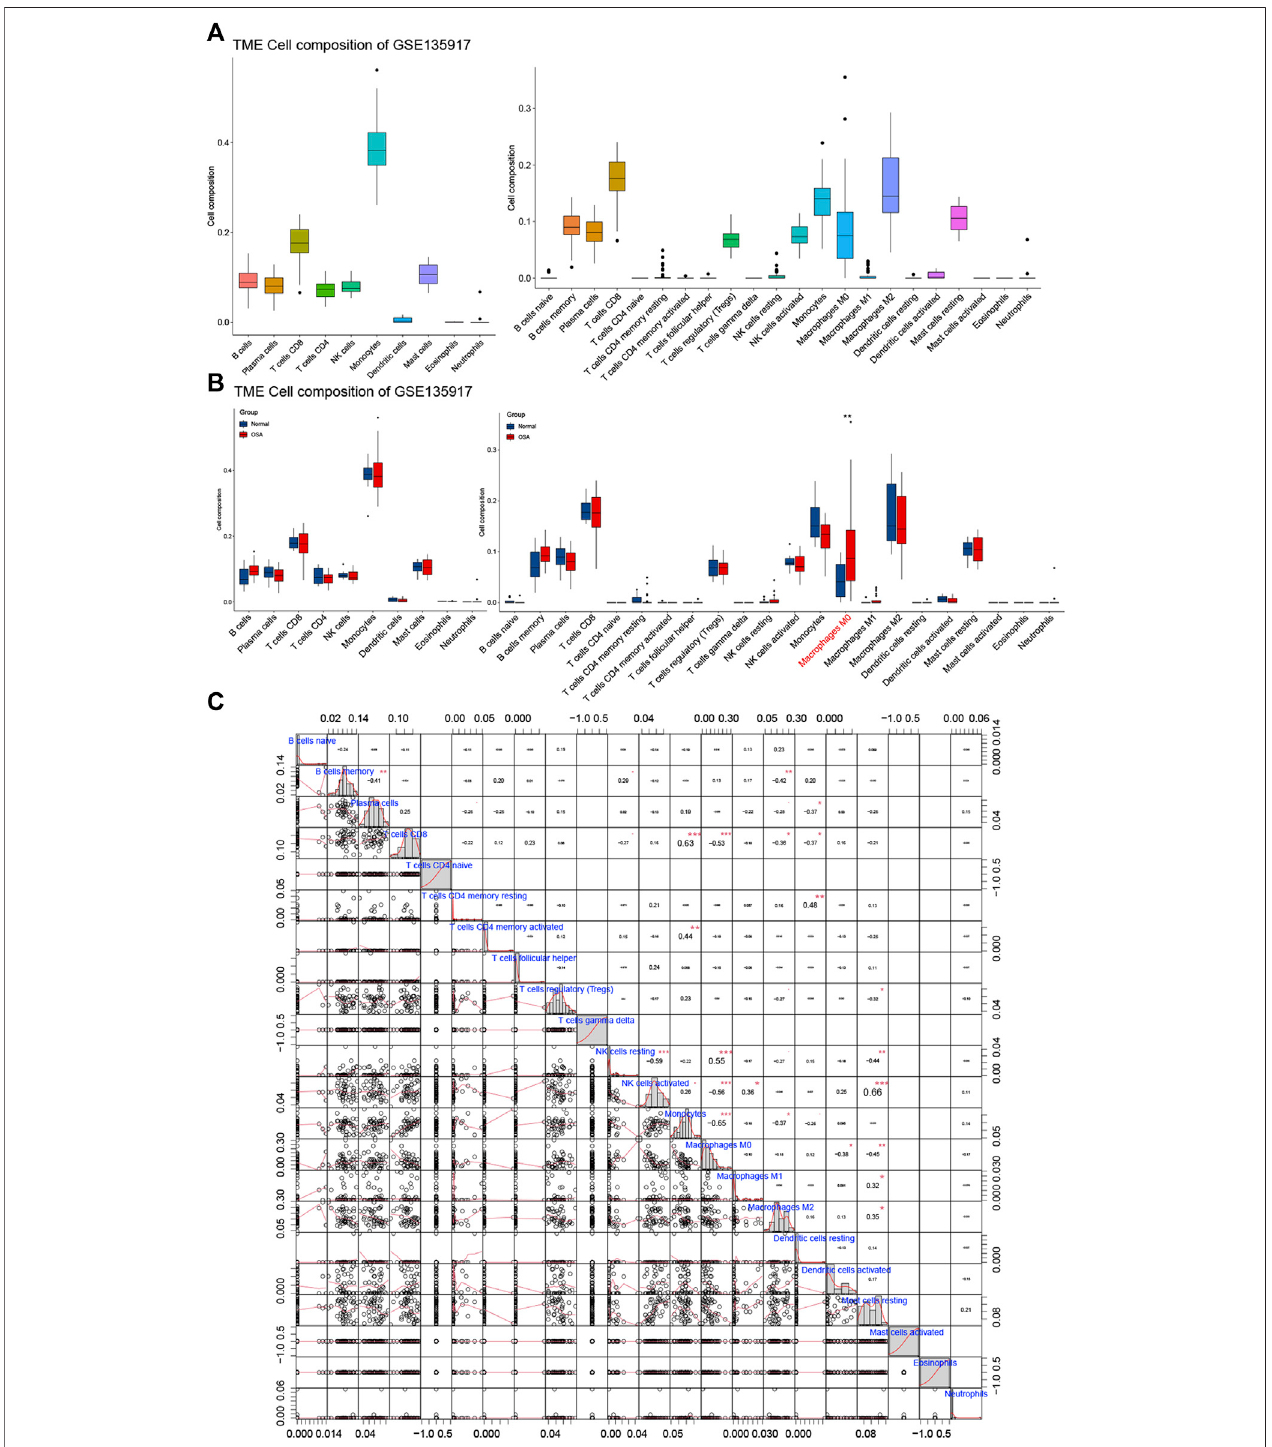
FIGURE 8 | Immune cell in fi ltrate analysis. (A) The composition of the immune cell in fi ltrate in OSA. (B) The differential expression of different types of immune cells between normal and OSA tissues. (C) Correlation matrix of 22 types of immune cell proportions.